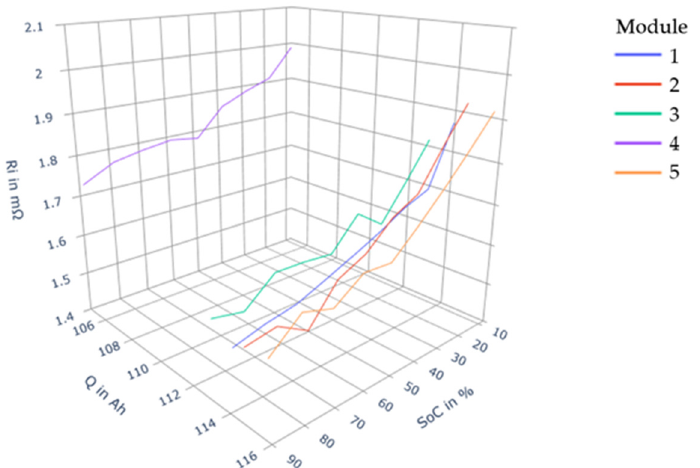
Figure 9. Three-dimensional (3D) characteristics of CI measurements. The increase in the internal resistance to low SOC is noticeable, and Module 4 (printed in purple color) has a significantly larger internal resistance curve. The charge quantity is plotted negatively because it is counted negatively in the discharge